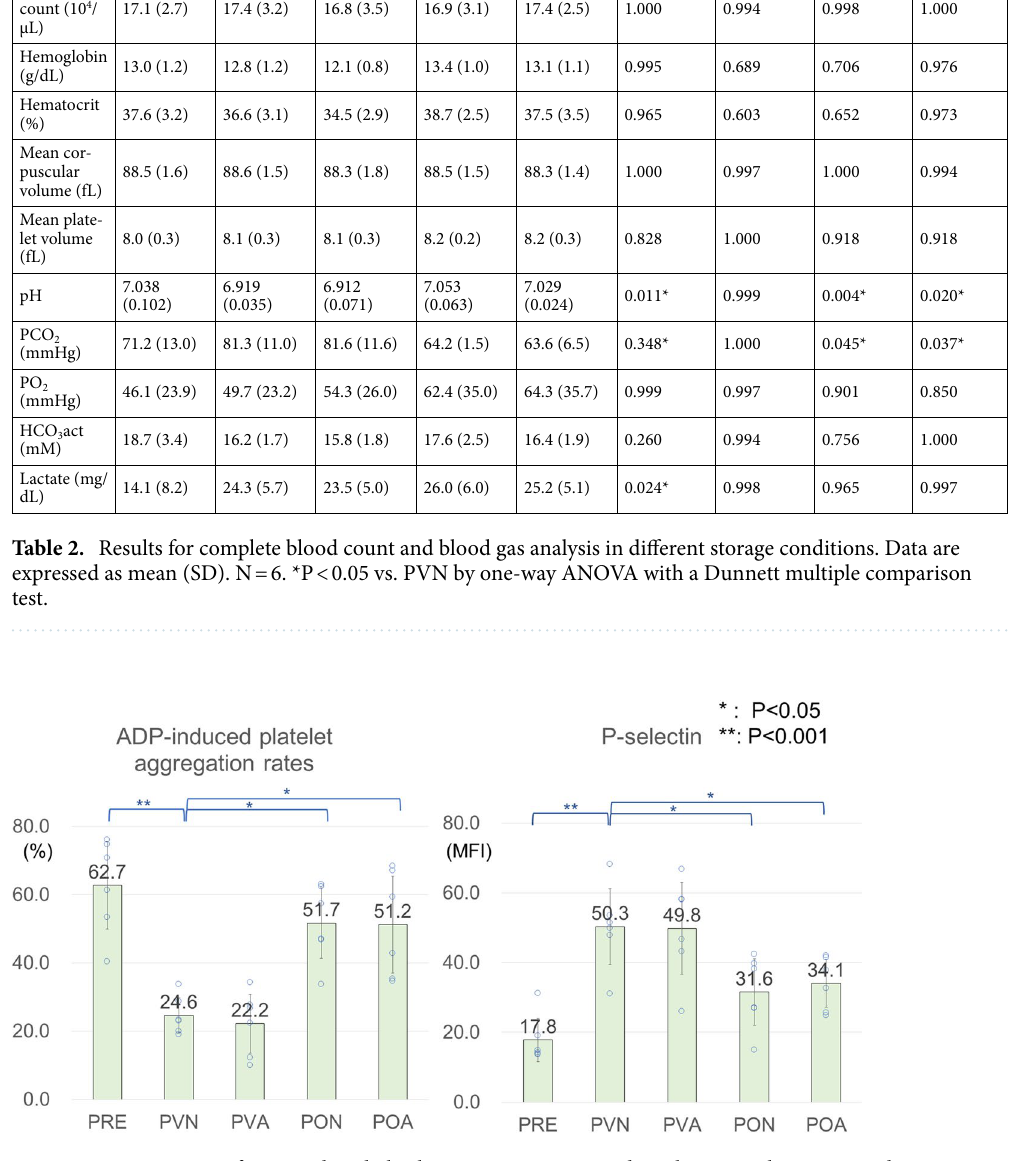
Figure 2. Comparison of ADP-induced platelet aggregation rates and P-selectin results. Compared to PRE, ADP-induced platelet aggregation rates in PVN and PVA storage decreased significantly and P-selectin expression of PVN and PVA increased significantly. Whole blood storage in polyolefin bags (PON and POA) maintained twofold higher ADP-induced platelet aggregation rates and a significantly lower P-selectin expression compared to PVN. *P < 0.05, **P < 0.001 vs. PVN by one-way ANOVA with a Dunnett multiple comparison